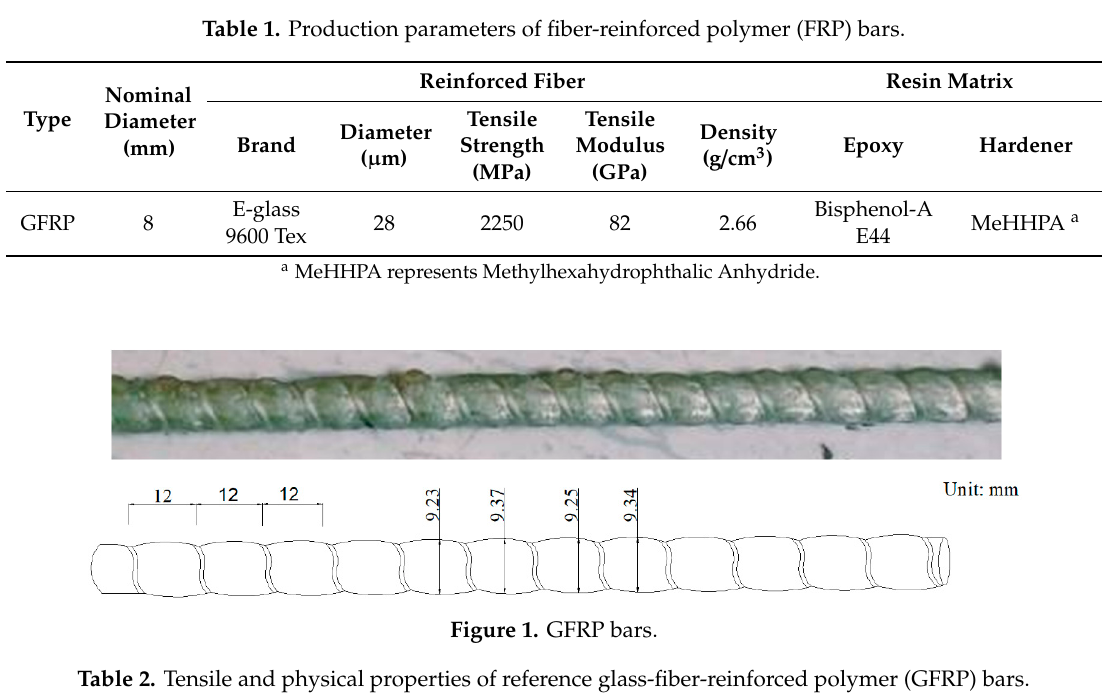
Table 2. Tensile and physical properties of reference glass-fiber-reinforced polymer (GFRP) bars.